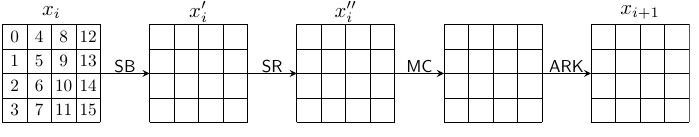
Figure 1. AES round